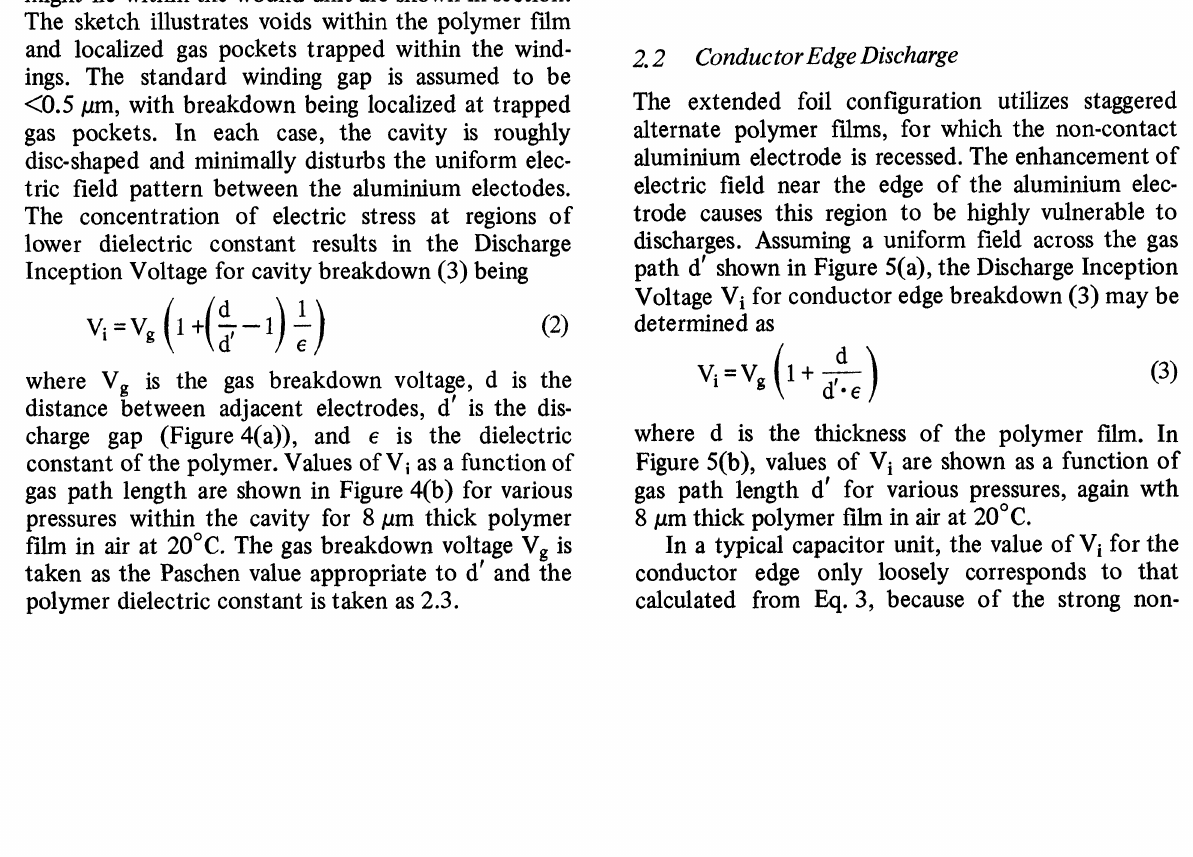
- Void in the film as viewed with reflected light. Typical void densities are 25 to 100 cm Cavity discharges: (a) Cavity model, (b) Cavity discharge inception voltage versus gap for various